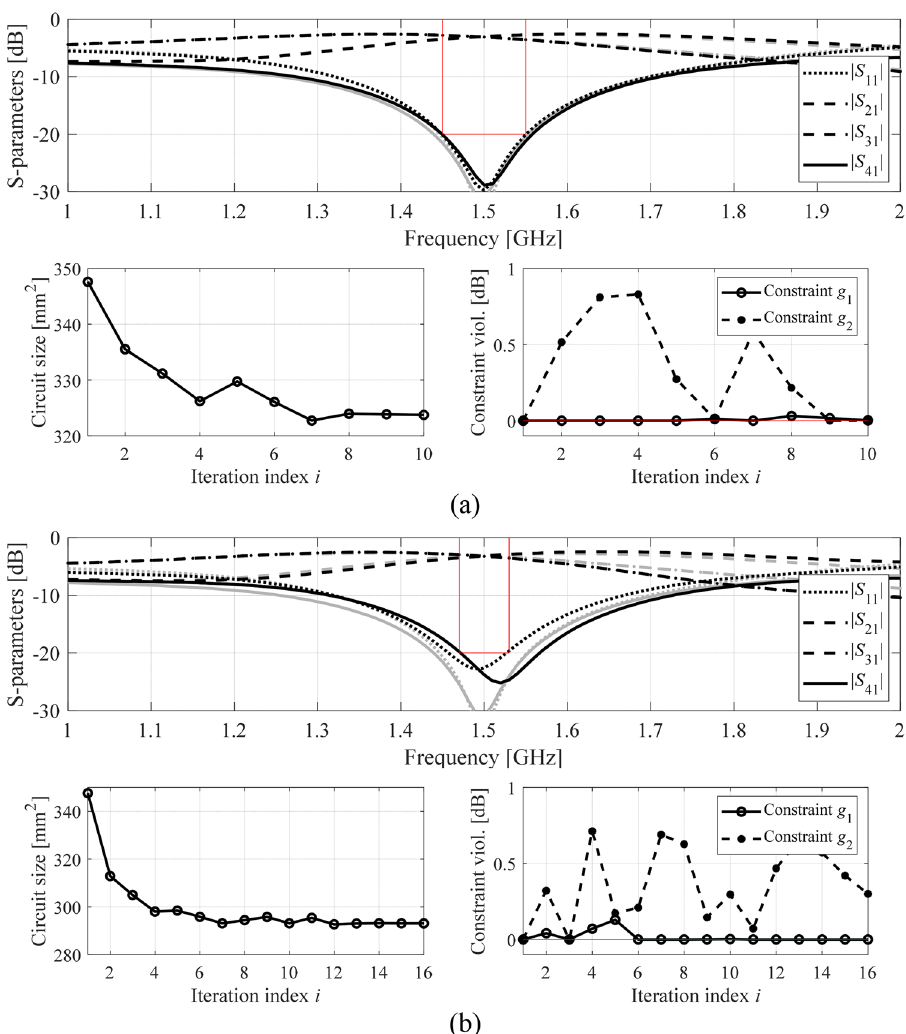
Figure 4. Initial (gray) and optimized (black) S -parameters of Circuit I. The vertical and horizontal lines mark the target operating bandwidth and the acceptance level for the matching | S 11 | and isolation | S 41 | responses. Also shown is the evolution of the circuit size and constraint violations (in case of feasibility, violations shown as zero): ( a ) design scenario I (bandwidth 1.45–1.55 GHz), ( b ) design scenario II (bandwidth 1.47–1.53